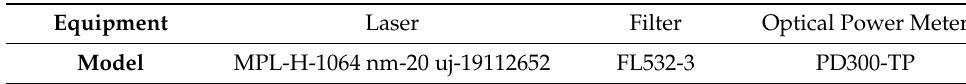
Figure 9. Experimental platform. Table 10. The models of equipment used in the experiment.